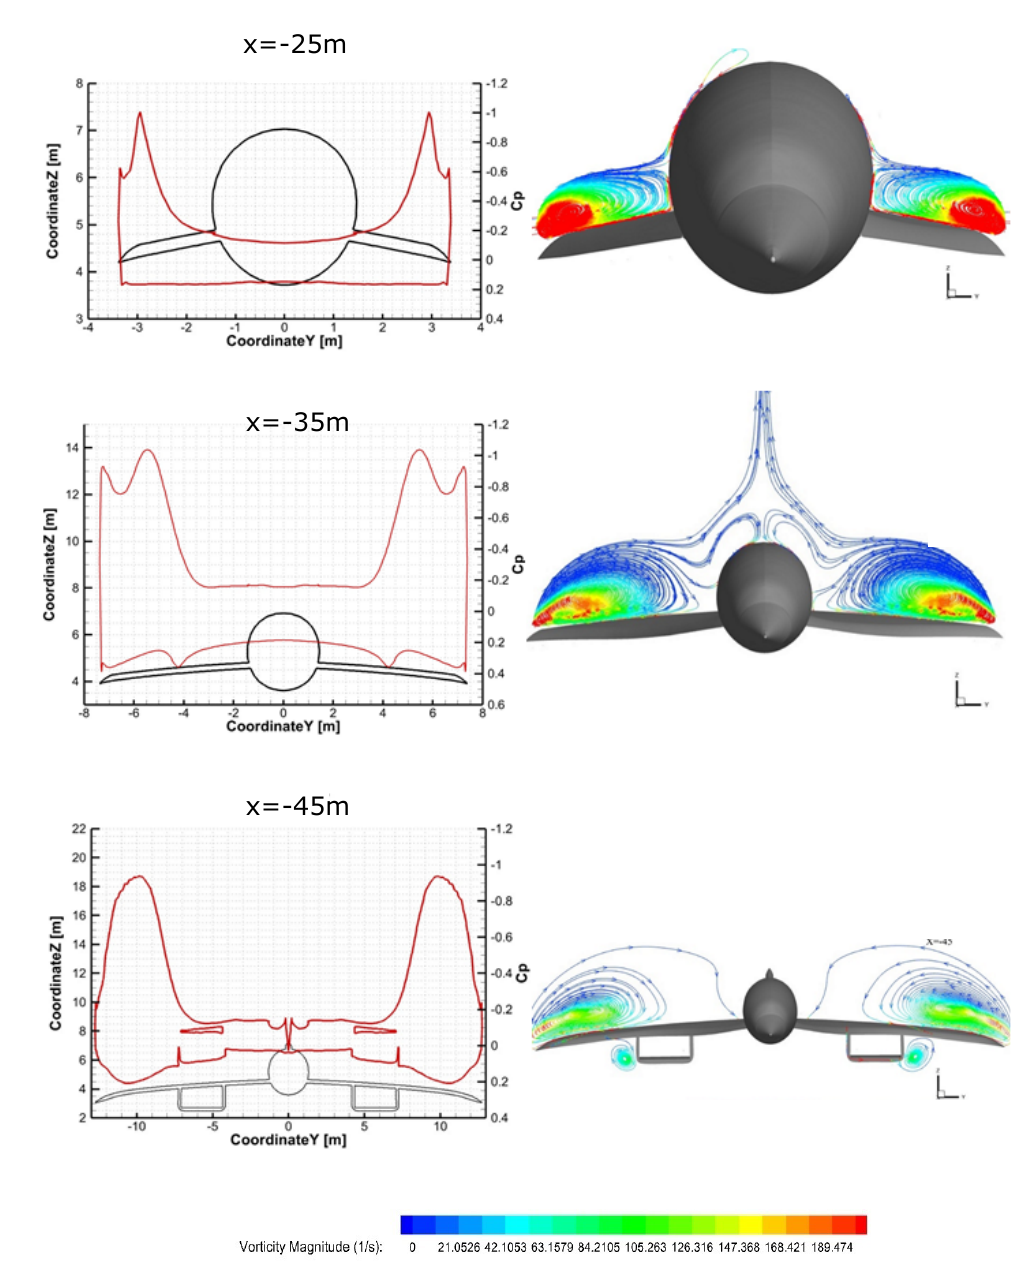
Figure 8. Flowfield results at α = 10 ◦ . Pressure distribution ( left ) and vorticity magnitude ( right ). The streamlines representing the attachment regions divide the undisturbed flow, directed toward the trailing edge, from the primary flow headed toward the wing